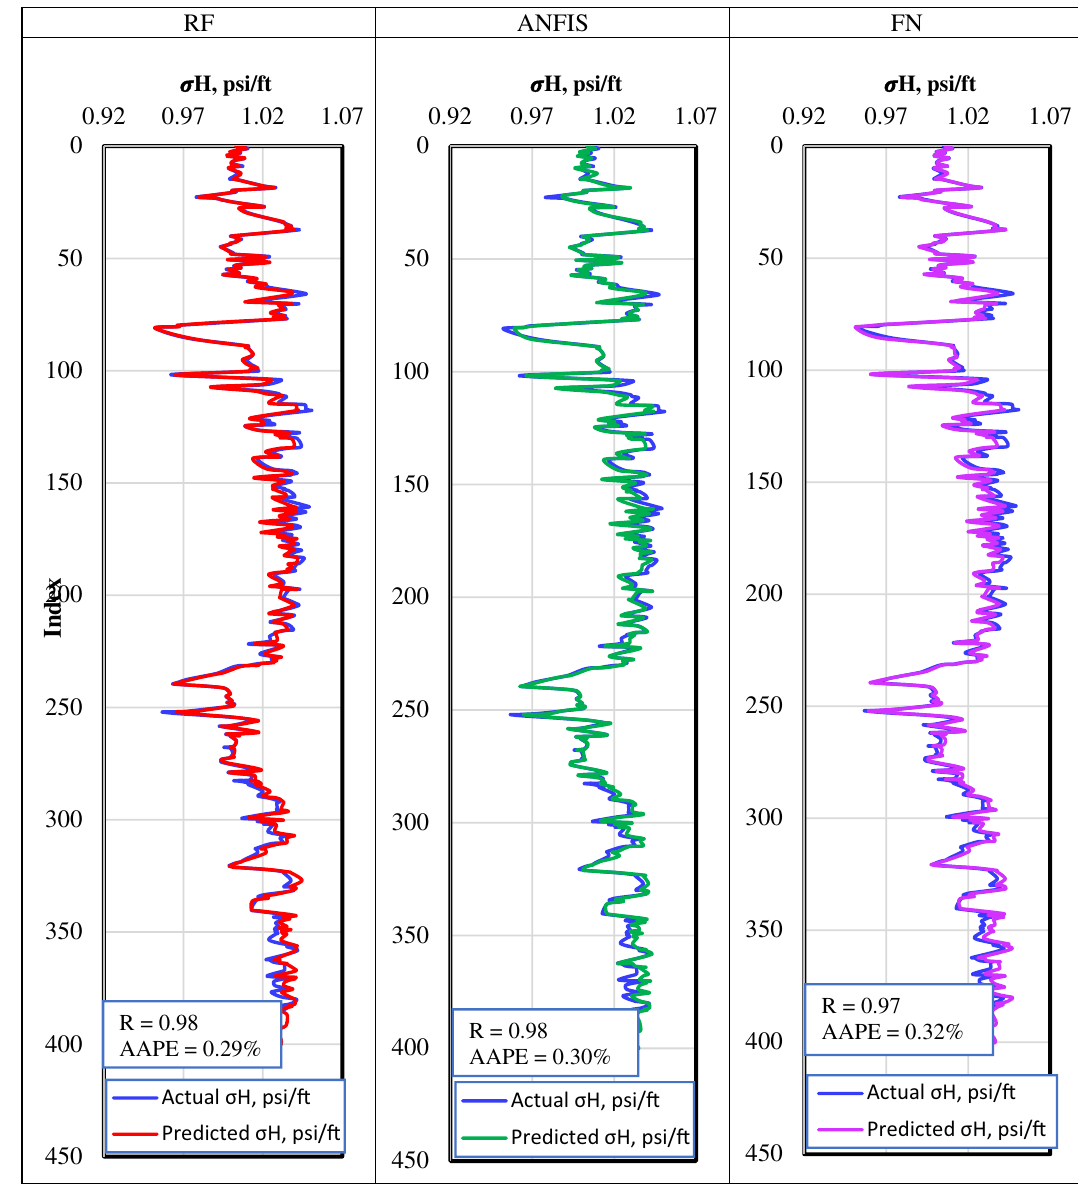
Figure 8. Actual versus the predicted σ h gradient for the validation dataset from ( a ) RF model, ( b ) ANFIS model, and ( c ) FN model.